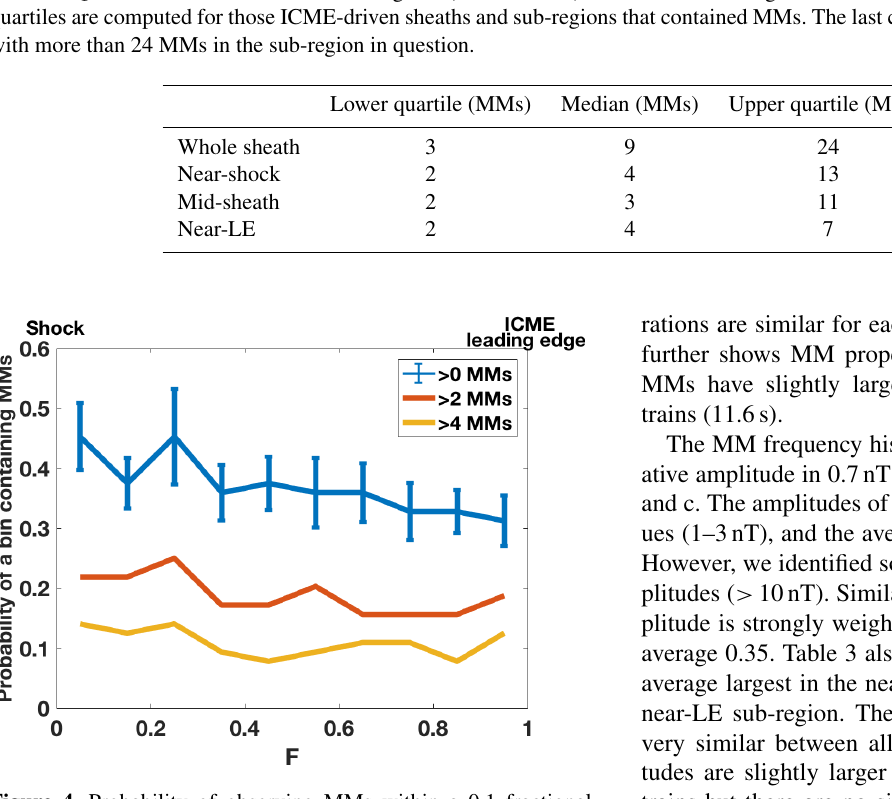
Figure 4. Probability of observing MMs within a 0.1 fractional distance ( F ) bin as a function of F from the ICME-driven shock ( F = 0 refers to the shock and F = 1 to the ICME leading edge). The colors show different requirements for the number of MMs in a bin. The probability is defined as the ratio of the number of in- tervals containing MMs to the total number of intervals within each bin (64 for all intervals). The error bars of the blue curve represents the division of MMs within the whole sheath and are defined as the ratio of the number of MMs observed within each bin to the total number of MMs within the whole F interval from 0 to 1. We only consider here those ICME-driven sheaths that contained MMs. We have checked that the distributions are not biased due to the sheaths containing a large number of